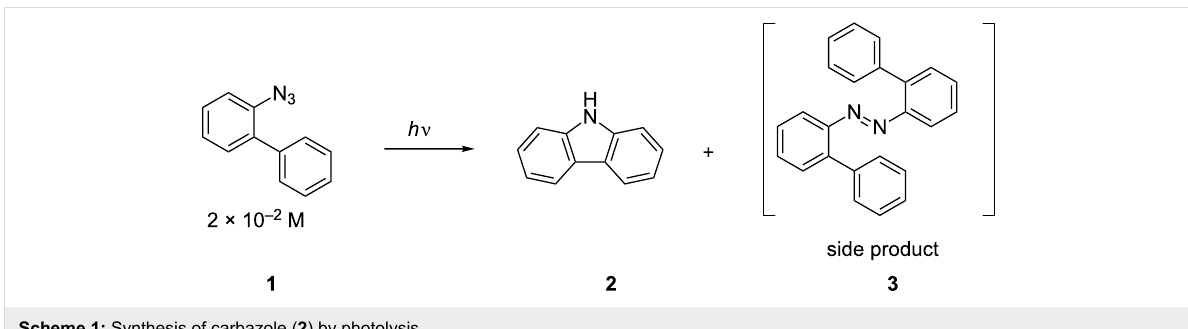
Scheme 1: Synthesis of carbazole ( 2 ) by photolysis.